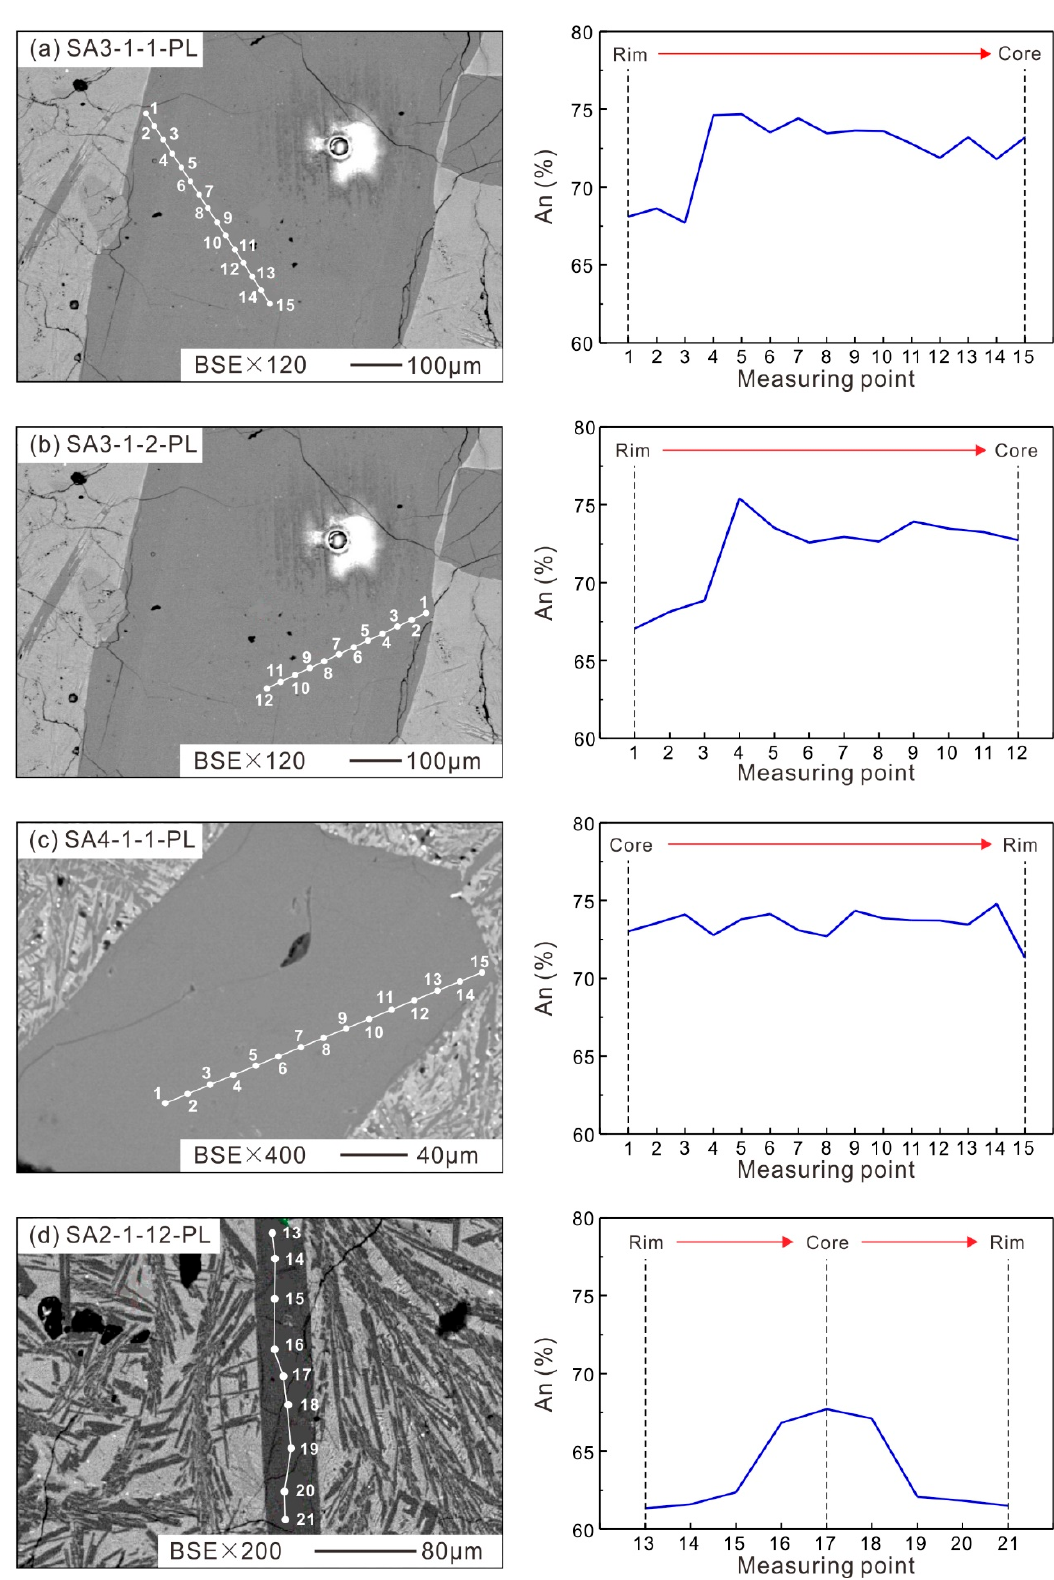
Figure 7. Backscattered electron images of ( a–c ) plagioclase phenocrysts and ( d ) a microphenocryst; along with the corresponding variational curves for measured anorthite proportions (mol%).